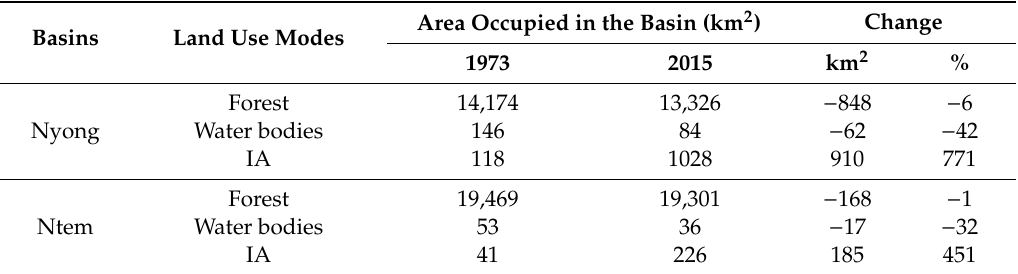
Figure 6. Spatial distribution of the main land use patterns in the studied watersheds at two dates. Table 7. Evolution of the main land use modes in the Nyong and Ntem